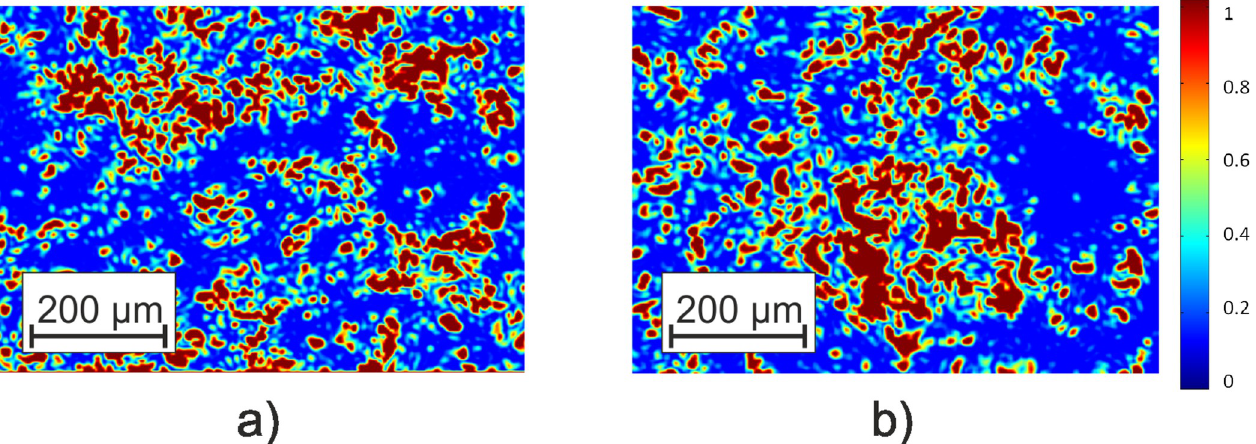
Fig 2. Microscopic (4x) polarization-visualized images of the optically anisotropic component of the histological sections of the myocardium of control (a) and diagnosed (b) groups.